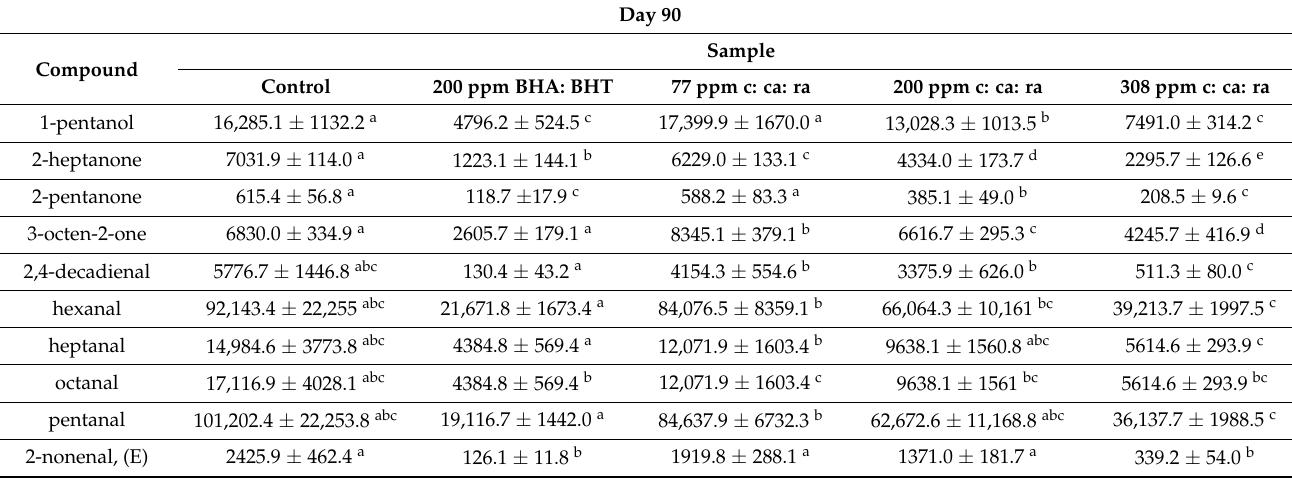
Table A10. Levels of volatile compounds ( µ g/kg of FFMP) as measured with SPME-GC-MS analysis in FFMPs with or without antioxidants, after accelerated storage (40 ◦ C, RH 23%) for 90 days 1, 2, 3, 4